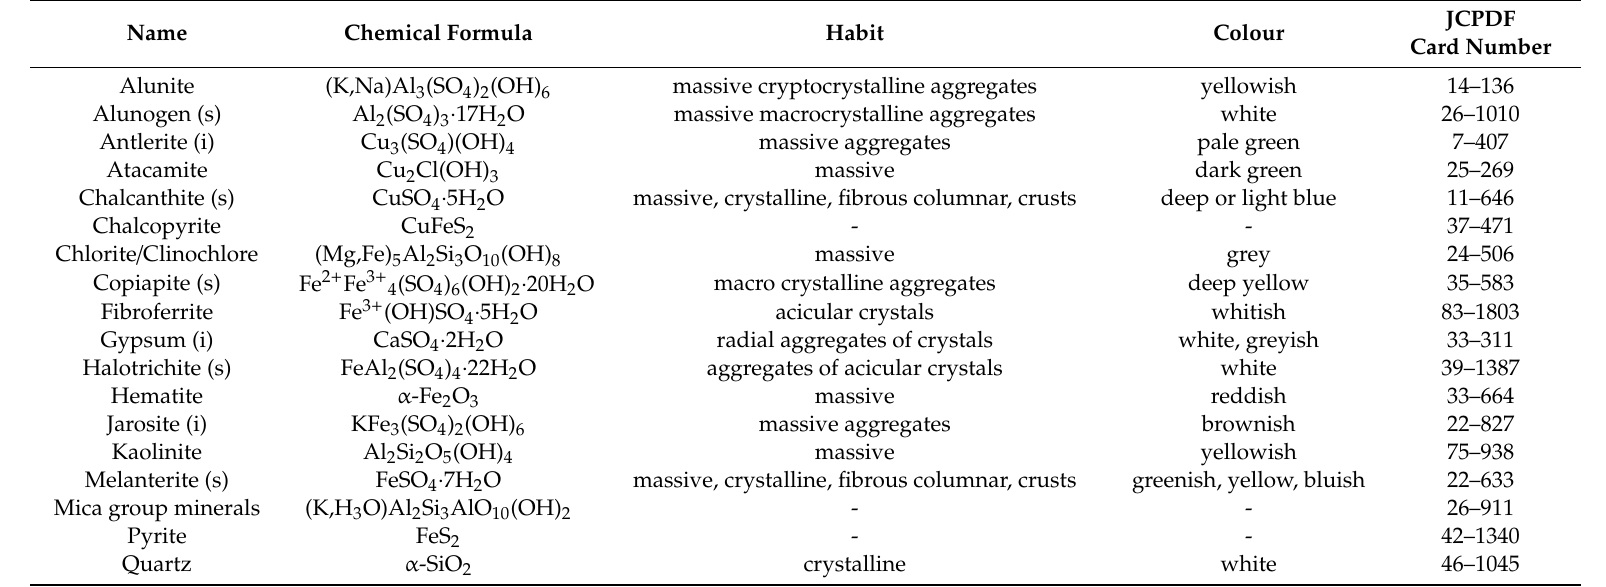
Table 1. Inventory of the mineralogical phases identified by XRD (alphabetical order) and principal characteristics; data about solubility are from Hammarstrom [22]: s, highly soluble in water; i, relatively insoluble in water; -, non-individualized minerals when observed under the